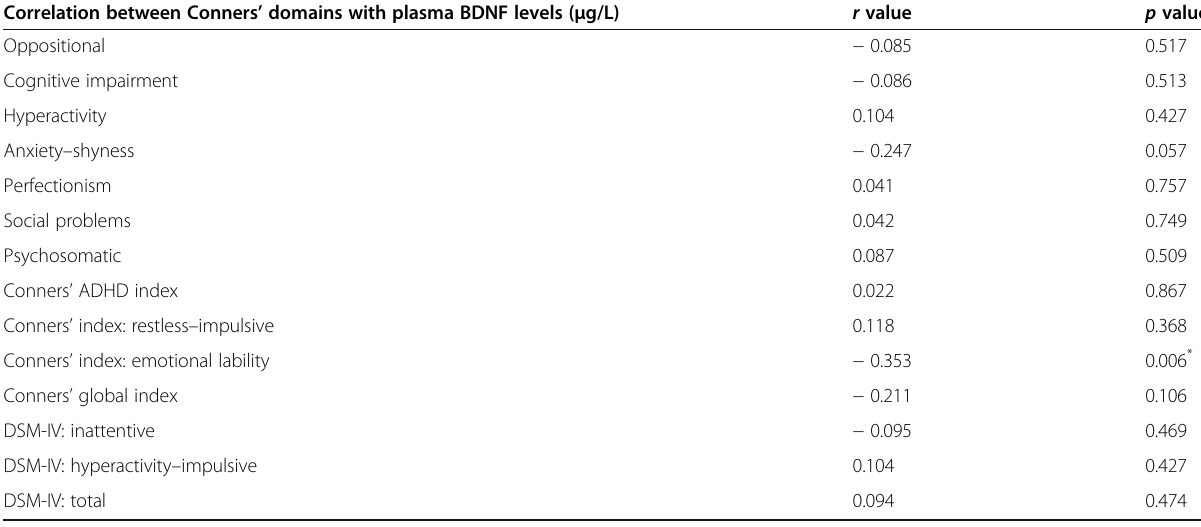
Table 5 Correlation between Conner ’ s Parent Scale scores and BDNF level among cases Correlation between Conners ’ domains with plasma BDNF levels ( μ